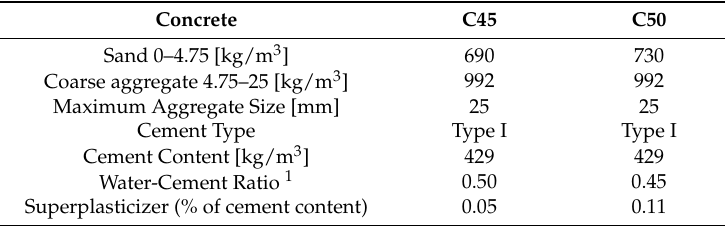
Table 1. Mix design of base concrete C45 and C50.